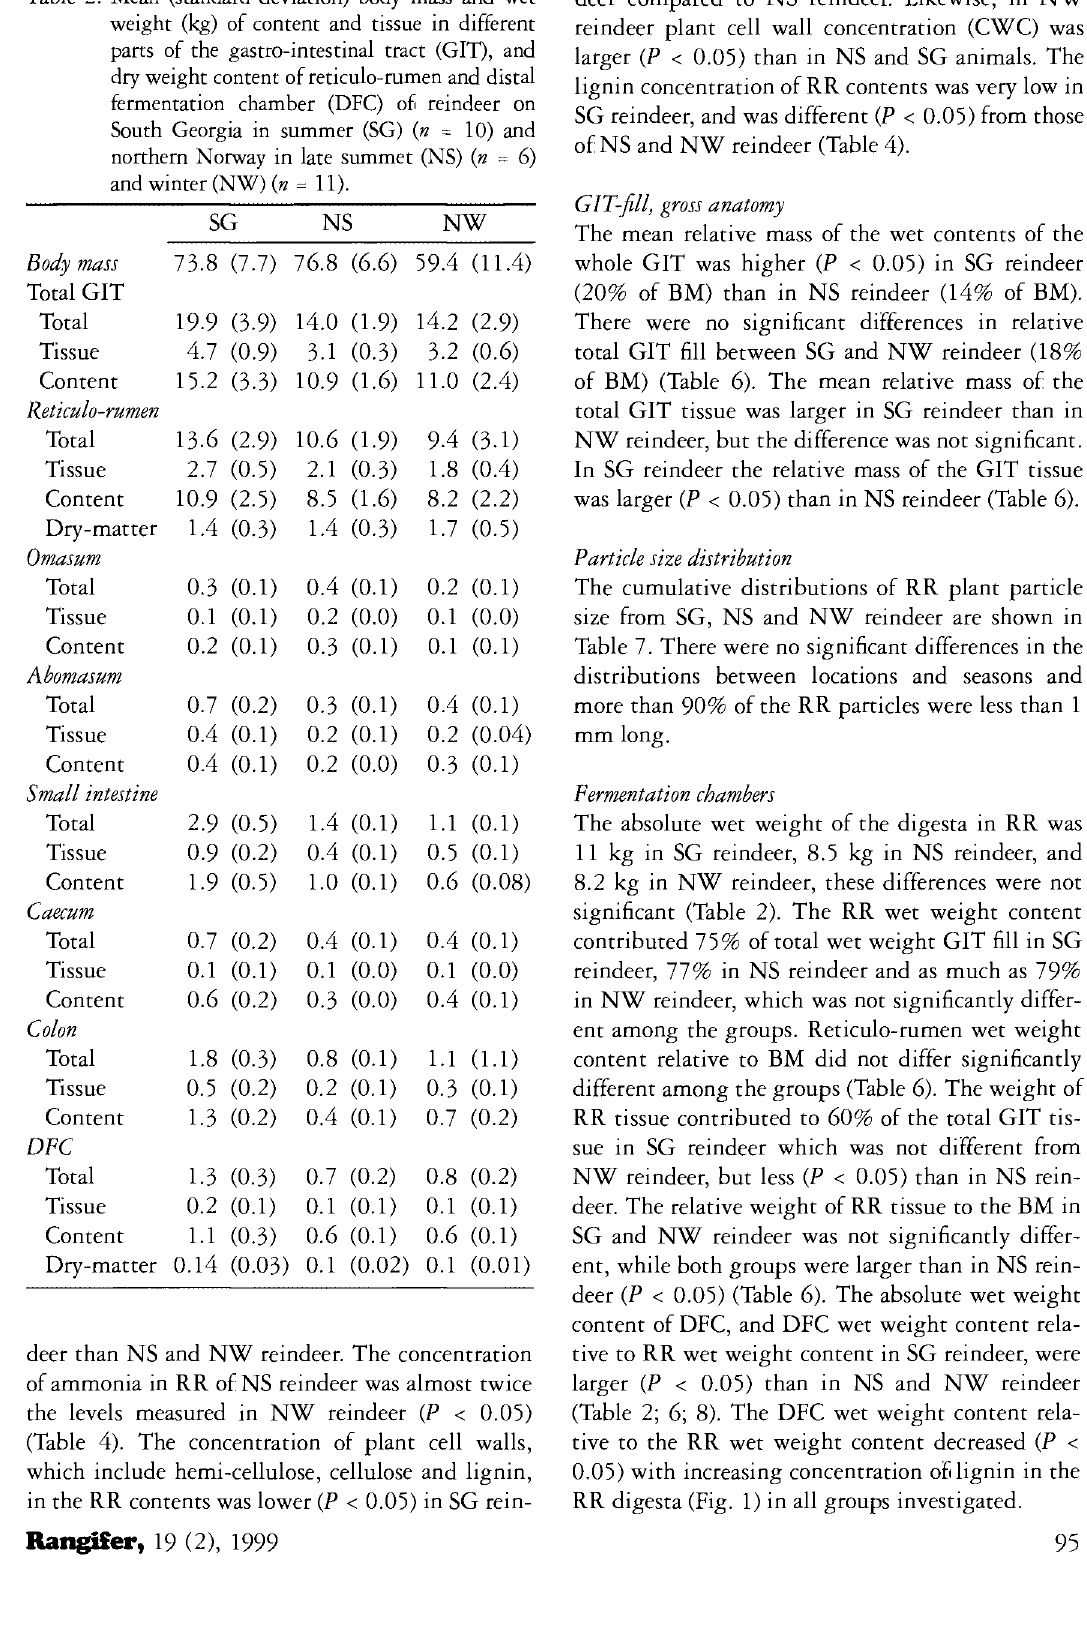
deer compared to NS reindeer. Likewise, in NW reindeer plant cell wall concentration (CWC) was larger (P < 0.05) than in NS and SG animals. The lignin concentration of RR contents was very low in SG reindeer, and was different (P < 0.05) from those of NS and NW reindeer (Table 4).